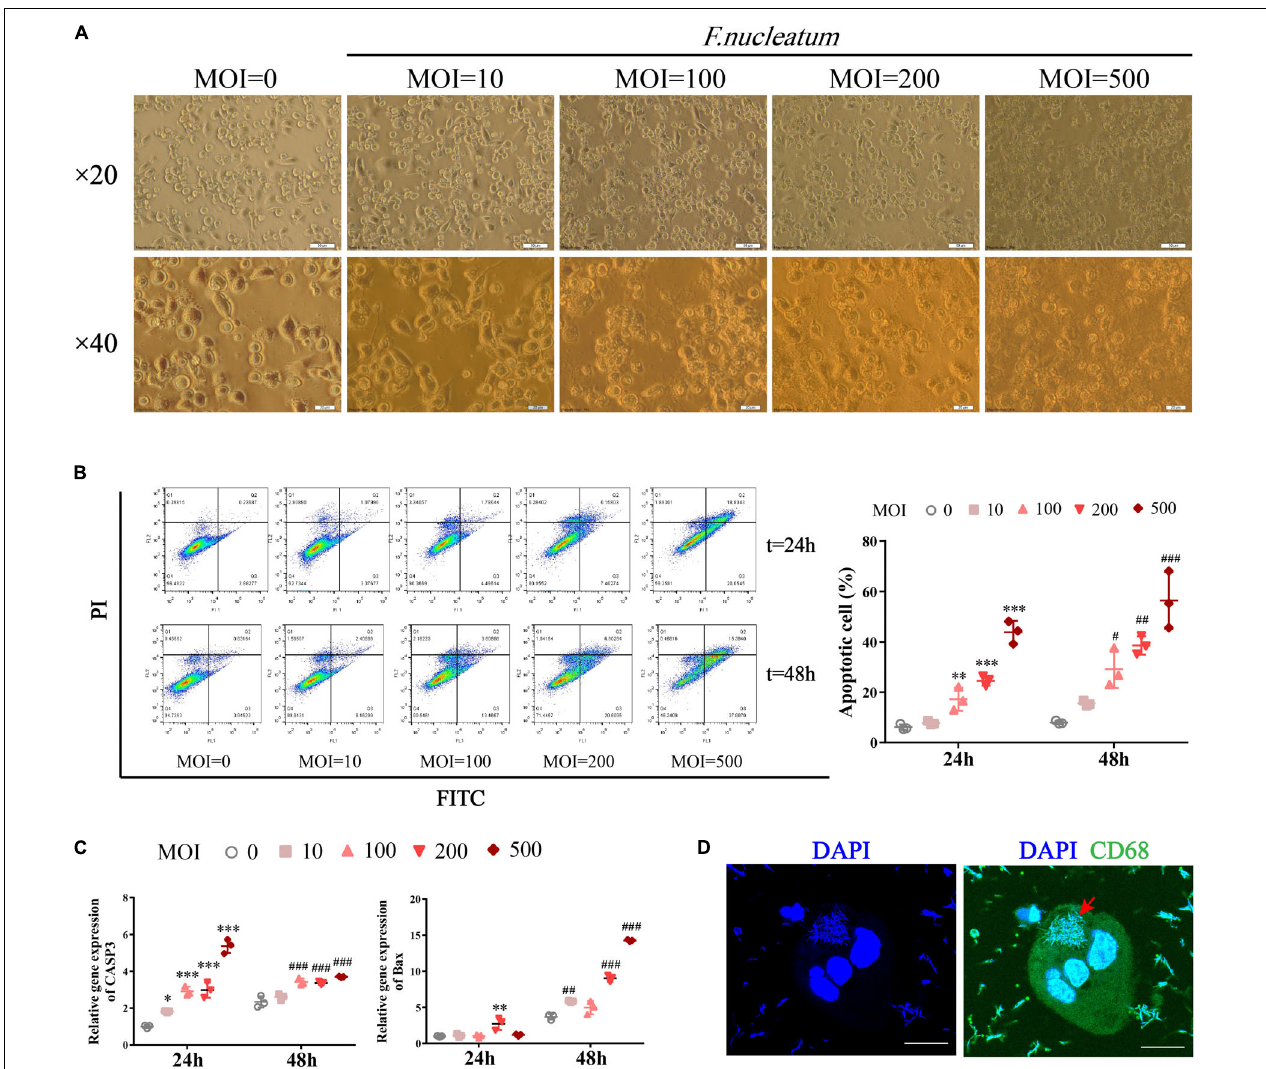
FIGURE 5 | F. nucleatum can invade and induce macrophage apoptosis. To establish a co-culture model, dTHP1 were infected with F. nucleatum at different MOI of 0, 10, 100, 200, and 500 for 24 or 48 h, respectively. (A) Morphology of infected dTHP1 cells ( × 20, × 40) was observed by a light microscope at 24 h. Scale bars, 50 and 20 µ m. (B) The apoptotic rate of dTHP1 cells under different MOI were analyzed by flow cytometry at 24 and 48 h. (C) qRT-PCR analysis of apoptosis genes expression in dTHP1 cells at different MOI. The fold change of mRNA was calculated relative to the 24 h control group. (D) Immunofluorescence cross-section through dTHP1 cell after 24 h exposure to F. nucleatum (MOI = 100) was observed by a confocal laser scanning microscope ( × 240). Scale bars, 10 µ m. The red arrow indicates the bacterium in the cytoplasm. Data represent the mean ± SD of three duplicates. ∗ p < 0.05, ∗∗ p < 0.01, ∗∗∗ p < 0.001 vs. control group (MOI = 0, 24 h); # p < 0.05, ## p < 0.01, ### p < 0.001 vs. control group (MOI = 0, 48 h); The one-way ANOVA with Tukey’s post-hoc